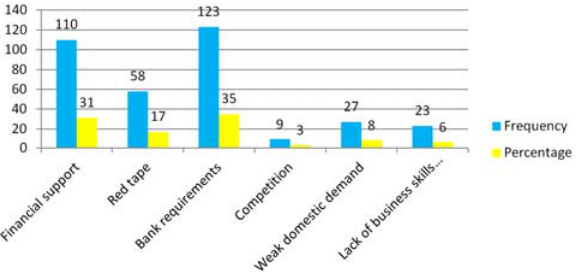
Fig. 5. Contributing factors to the South African Youth